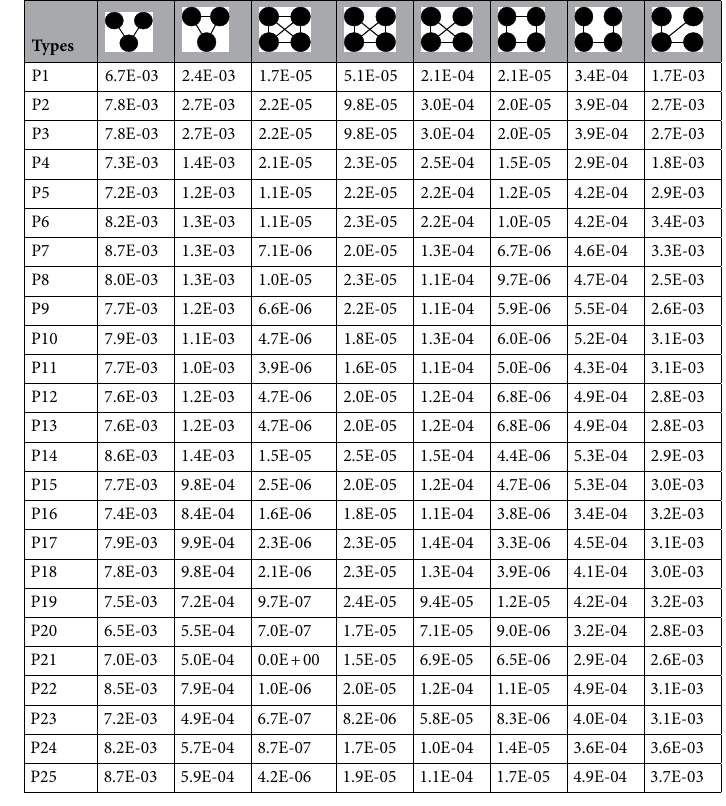
Table 4. Frequencies of each (anti-) motif in the 25 product structural networks.